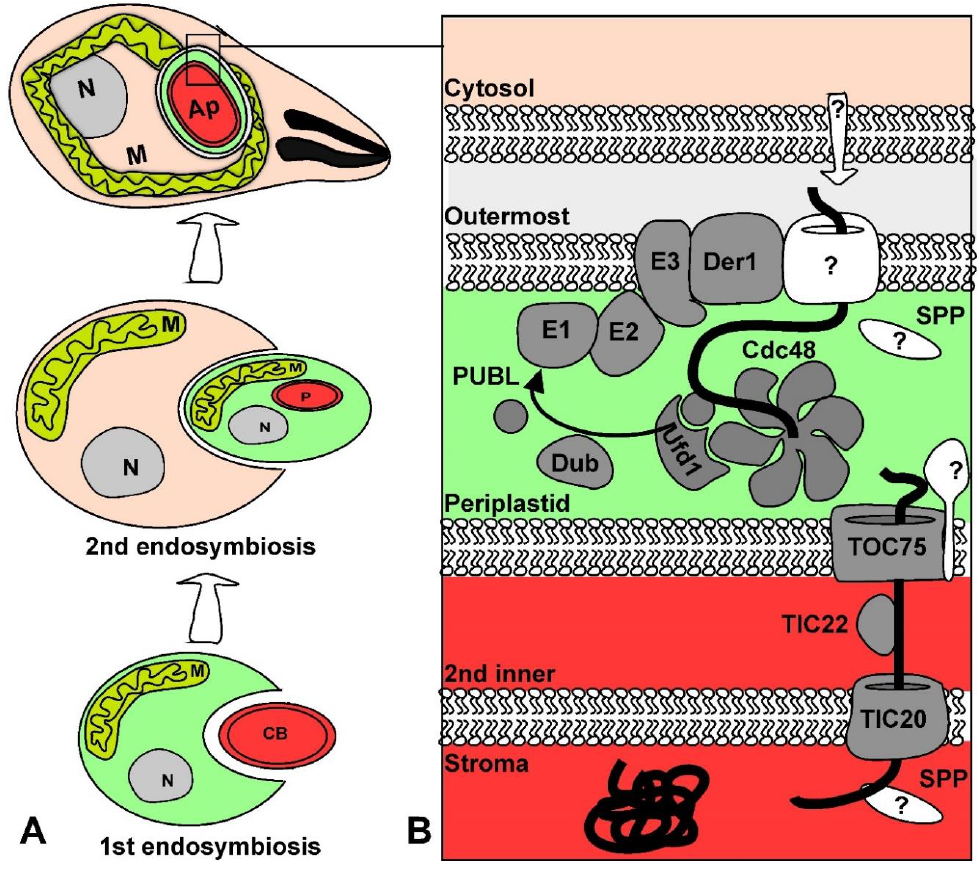
Figure 2. History of apicoplast acquisition, the resulting sub-compartments and the complexes involved in protein entry into the apicoplast compartments. The schemes are color coded to highlight the origin of each compartment (e.g., the PPC, corresponds to the algal cytosol (green)). ( A ) The scheme depicts the two endosymbiotic events that lead to the formation of the apicoplast. In the first event (bottom) a cyanobacterium (CB) is taken up by another cell. In the scheme, the host cell has a mitochondrion (M) and nucleus (N), however this is only one of a few models. In the second event, a eukaryotic cell with mitochondria (M) and a cell-nucleus (N) takes up a red algal cell along with its primary plastid (P) which evolved to a fully integrated secondary plastid in the apicomplexans — the apicoplast (AP); ( B ) Proteins participating in apicoplast protein import in each sub-compartment are depicted. Predicted components for which the apicomplexan homologues have not been identified, or unknown pathways are in white. A translocating protein from the outermost membrane to the stroma is depicted as a black bold line. In the PPC, the components of the endoplasmic reticulum associated degradation (ERAD) and ubiquitination pathways are shown: Der1; Cdc48; Ufd1; ubiquitin activating enzyme (E1); ubiquitin conjugating enzyme (E2); ubiquitin ligase (E3); deubiquitinase (Dub) and the plastid ubiquitin-like (PUBL) protein. Like the apicomplexan mitochondrion, which shows divergent features compared to canonical mitochondria, the apicoplast also has features that are divergent from other plastids. One example is the re-tooling of autophagy to support apicoplast biogenesis. Autophagy is a conserved process